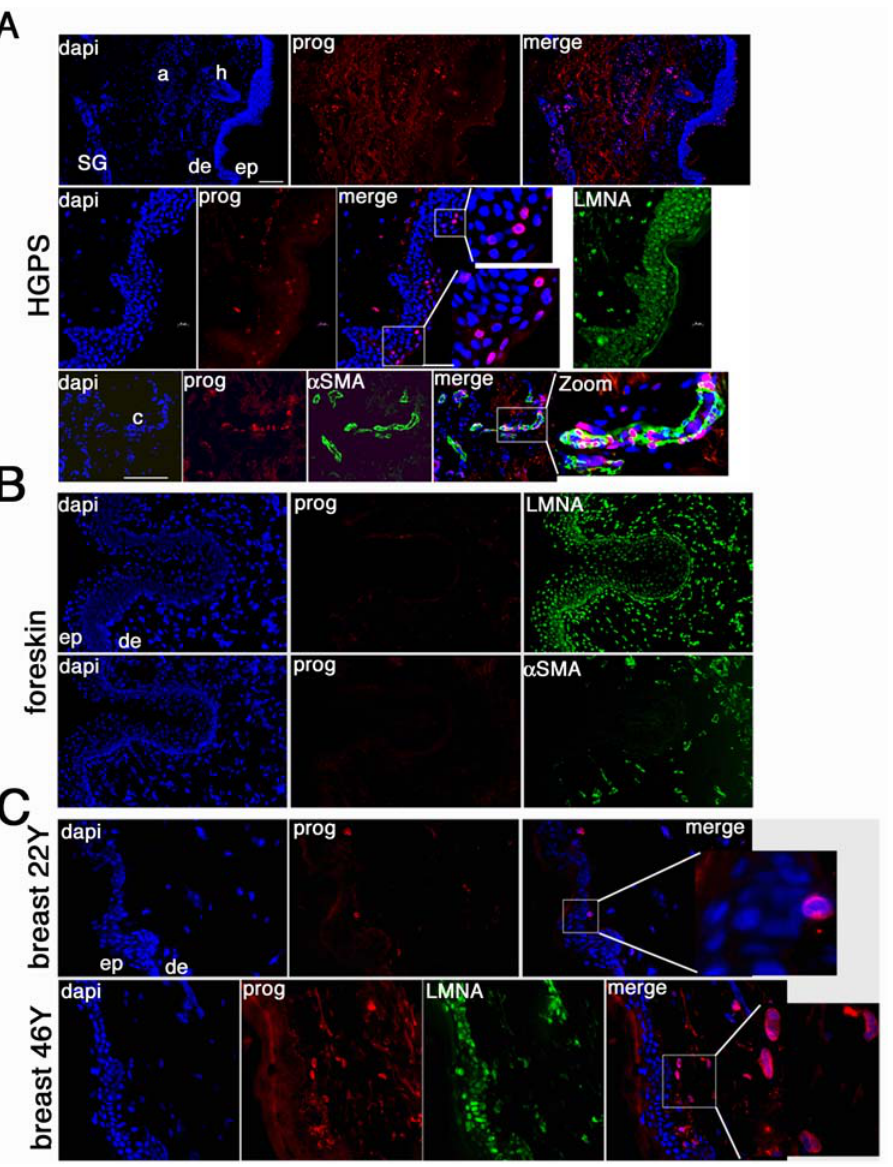
Figure 3. In situ localization of progerin on human skin sections derived from a subject with HGPS and from unaffected individuals. A , HGPS skin sections immunostained with anti-progerin (prog), anti-lamin A (LMNA) antibody, or anti- a smooth muscle actin antibody ( a SMA) and counterstained with a DNA stain (dapi). Morphologic entities are indicated: epidermis (ep), dermis (de), sweat glands (SG), capillary (c), arrector pili muscle (a), and hair follicle (h). B , Newborn foreskin sections immunolabelled with anti-progerin or anti- a SMA antibody. C , Breast skin sections from 22- and 46-year- old female subjects probed with anti-progerin and lamin A. The respective double or triple merged signals are indicated.